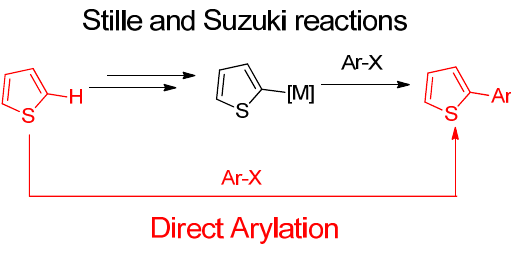
Figure 1. General Scheme for direct arylation reactions.